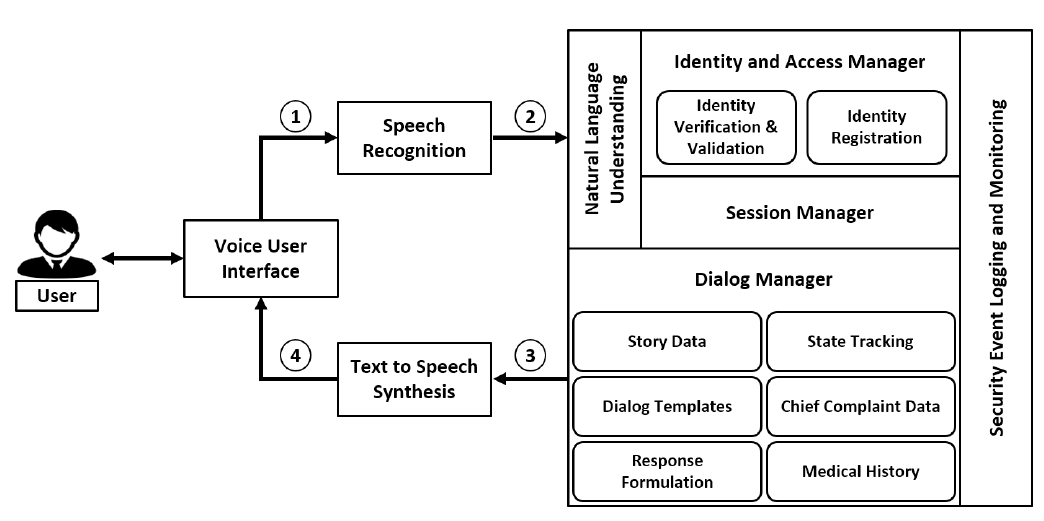
Figure 2. MIRA system